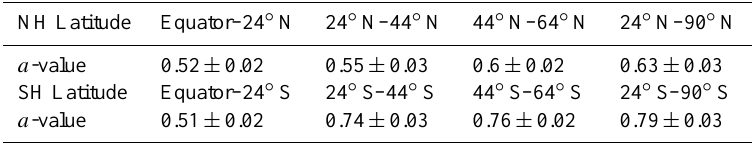
Table 1. DFA-exponent for the annual mean LSAT anomalies versus